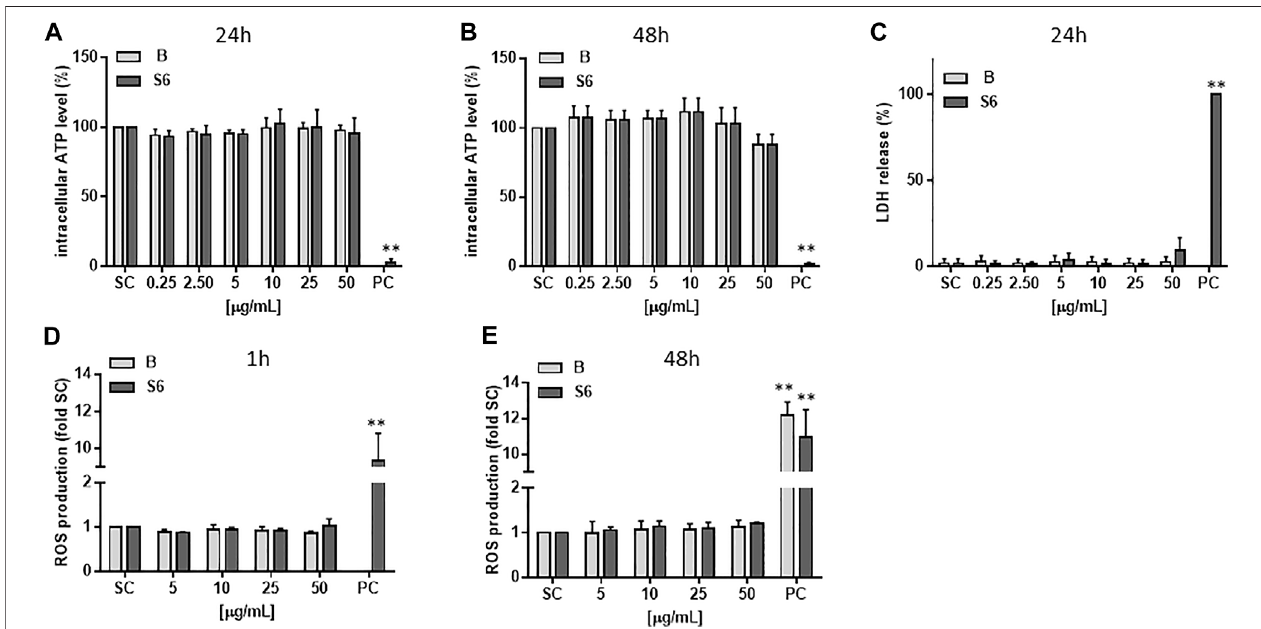
FIGURE 3 | Cytotoxicity and ROS production of Salix cortex extracts in differentiated HepaRG cells. ATP levels were analysed after (A) 24 h (B) 48 h of extract treatment. n (cid:1) 3 (C) LDH cell release was measured after 24 h extract treatment. 0.2% Triton-X was used as positive control (PC). n (cid:1) 4 (D, E) ROS production was measured by EPR spectroscopy after (D) 1 h or (E) 24 h of extract treatment. 200 μ M menadione for 30 min. was used as positive control (PC). n (cid:1) 3. The values are presented as means + SD. Ordinary one-way ANOVA was used for statistical analysis, followed by a Dunnett test versus solvent control (SC: 0.5% destilled water) group. ** p <